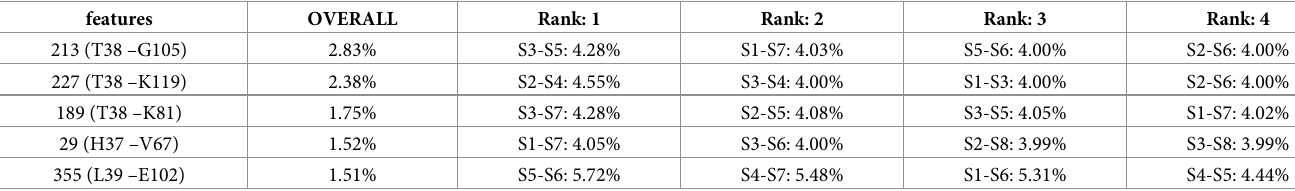
Table 1. Top 5 features in overall importance to distinguish difference states.